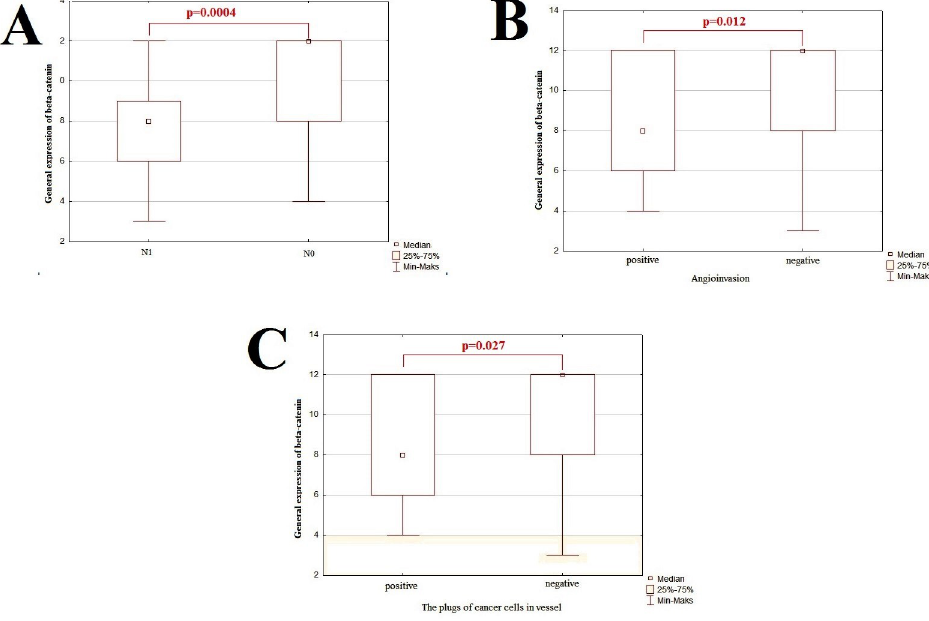
Fig 2. The graphic representation of results for general expression of β -catenin examined by IHC technique. The x- axis shows individual clinicopathological features and the y-axis shows IRS score values for IHC staining. The p-value < 0.05 was considered as a statistically significant. Correlation between general β -catenin immunoexpression of PCa and presence of lymph node metastasis (A); angioinvasion (B) and presence of plugs of tumor cells in the vessel (C).